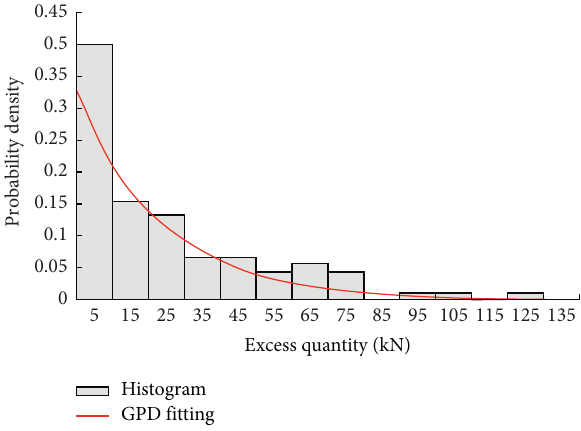
Figure 16: The PDF of the GPD for cable force excess quantity.